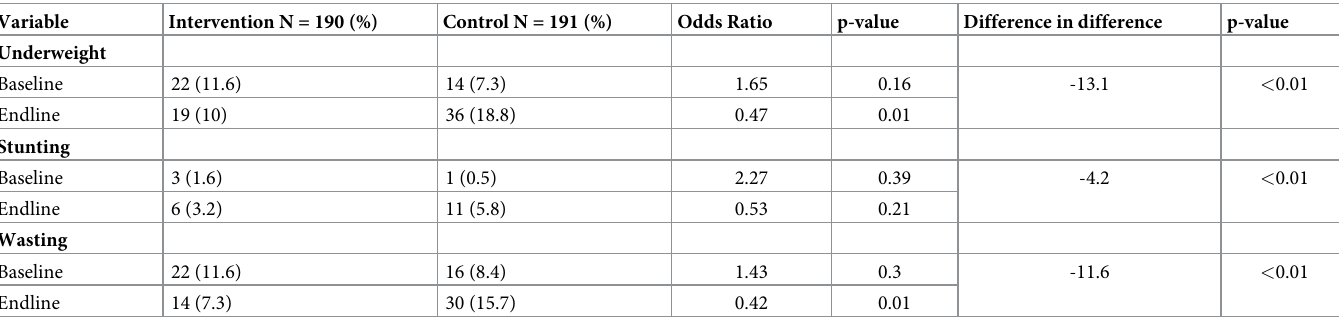
Table 3. The proportion of underweight, stunting and wasting in the infants at baseline and end line in the intervention and control group. Variable